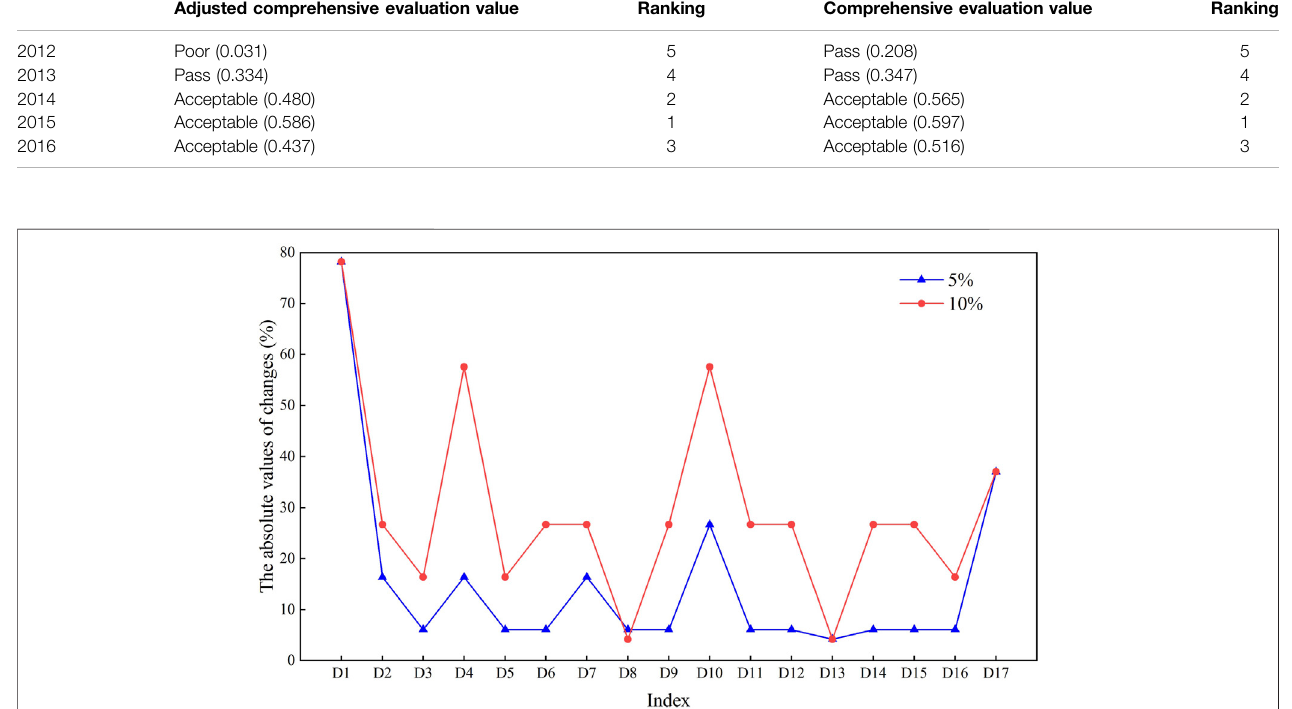
FIGURE 4 | Absolute values of changes in assessment